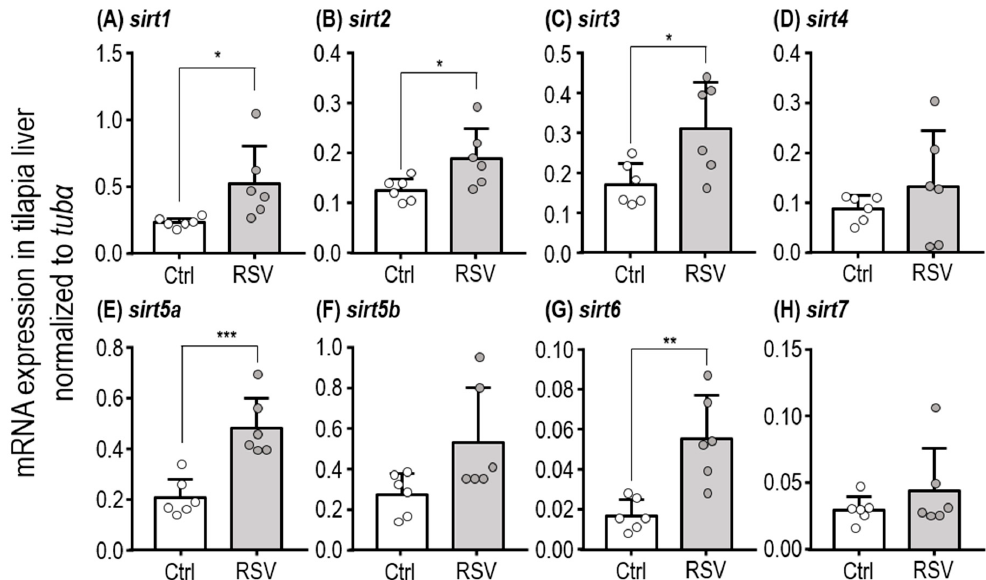
Figure 1. Relative expression levels of SIRT homologues in liver of tilapia fed with the Ctrl and RSV-diet for three days. qPCR analysis was used to compare liver expression levels of sirt1 ( A ), sirt2 ( B ), sirt3 ( C ), sirt4 ( D ), sirt5a ( E ), sirt5b ( F ), sirt6 ( G ), and sirt7 ( H ) between juvenile tilapia fed with Ctrl and RSV-diets. The tubulin alpha chain ( tub α ) was used as a reference gene. White dots and columns indicate the Ctrl group. Gray dots and columns represent the RSV group. Data are presented as mean ± SD ( n = 6). Asterisks indicate significant di ff erence (*: p < 0.05, **: p < 0.01, and ***: p < 0.001) between Ctrl and RSV